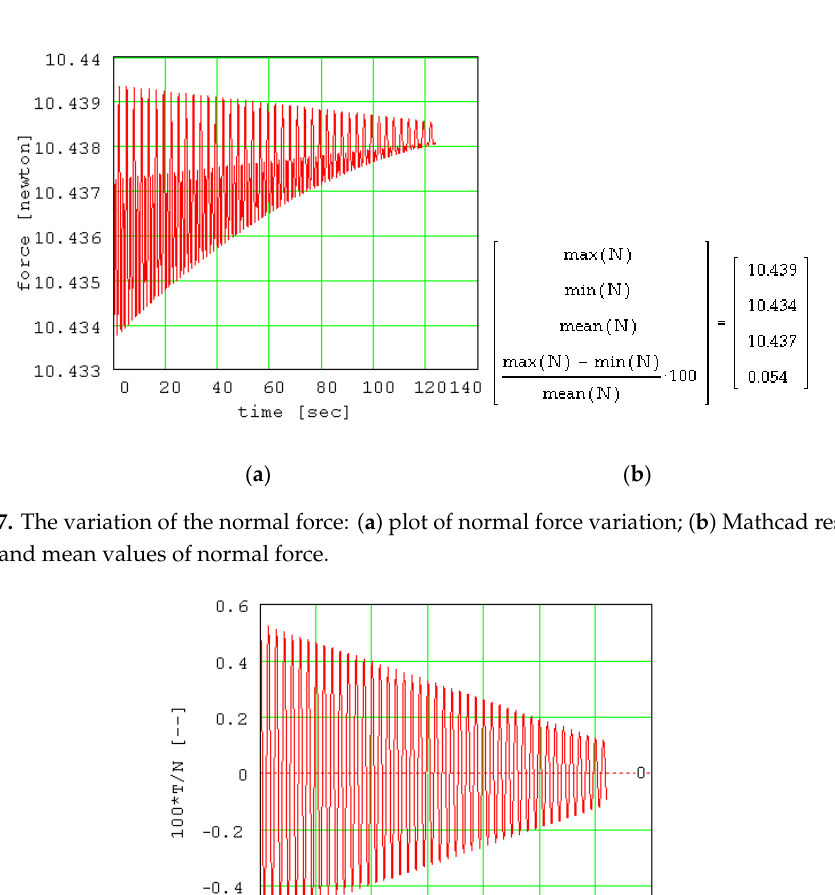
Figure 18. The ratio between friction force and normal force ( T/N ).